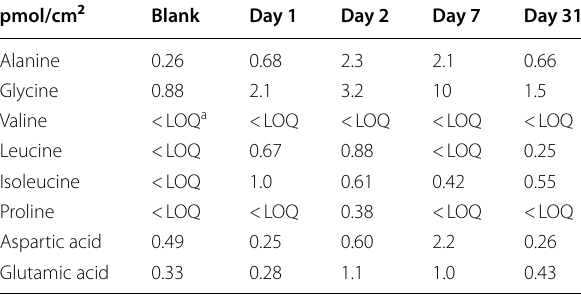
in the clean chamber of the ISAS/JAXA curation room